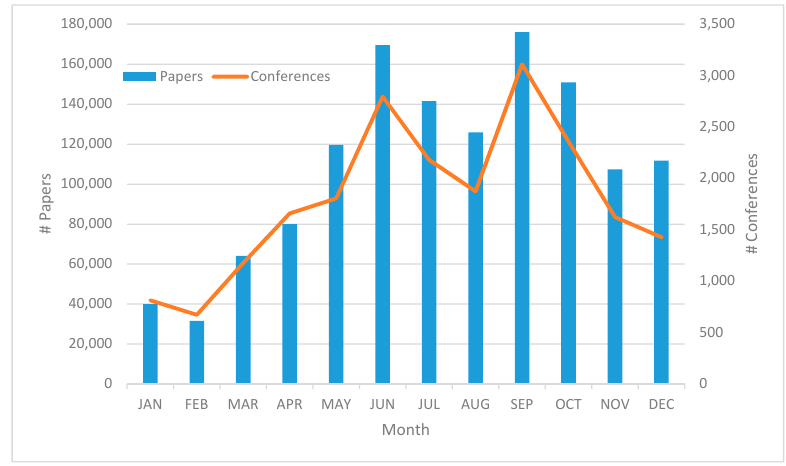
Figure 3. Number of papers published ( Left ) and conferences being held ( Right ) in individual months.